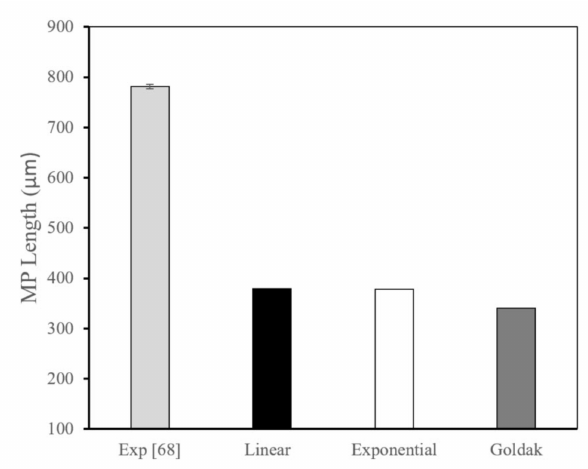
Figure 9. Validation of predicted melt pool depth.